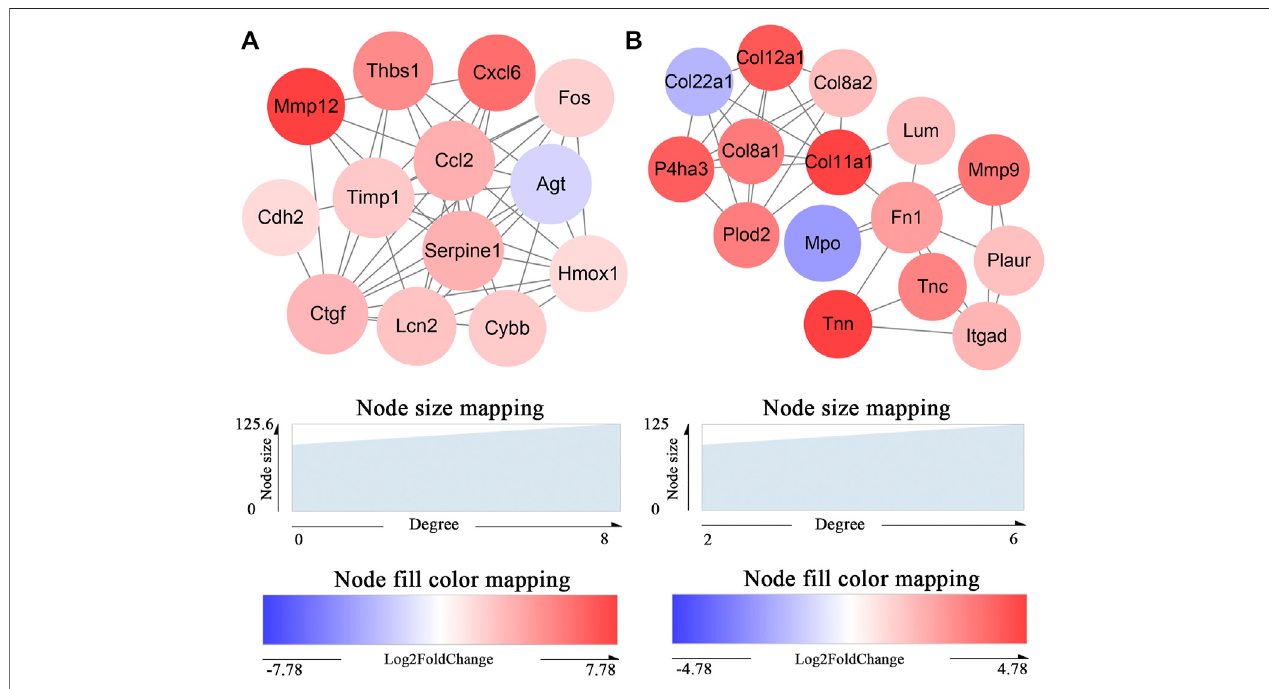
FIGURE5| Identi fi cationofkeyprotein clustersusingstring database and MCODEplugin (nodes > 10,score > 5). (A) Color-coded networkofproteinmodule1and their connection. (B) Color-coded network of protein module 2 and their connection. The nodes in (A) (B) indicate proteins. The edges represent protein interaction.